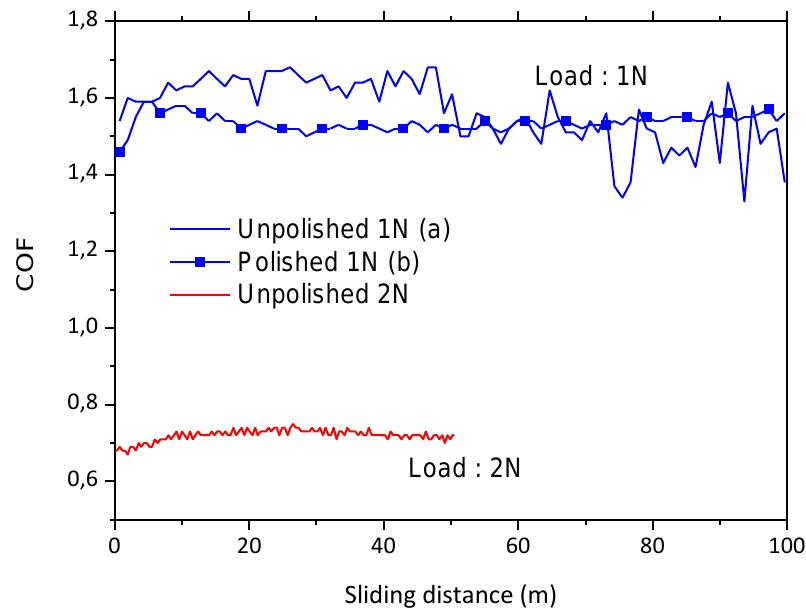
Figure 7. Friction coefficients, COF, for the porous layer against corundum counterbody with the sliding distance for loads of 1 N and sliding distance of 100 m ( a ) unpolished and ( b ) polished samples and for loads of 2 N and sliding distance of 50